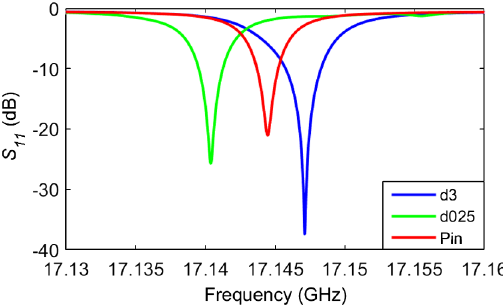
FIG. 18. Results of the S 11 measurement of the three HPBG